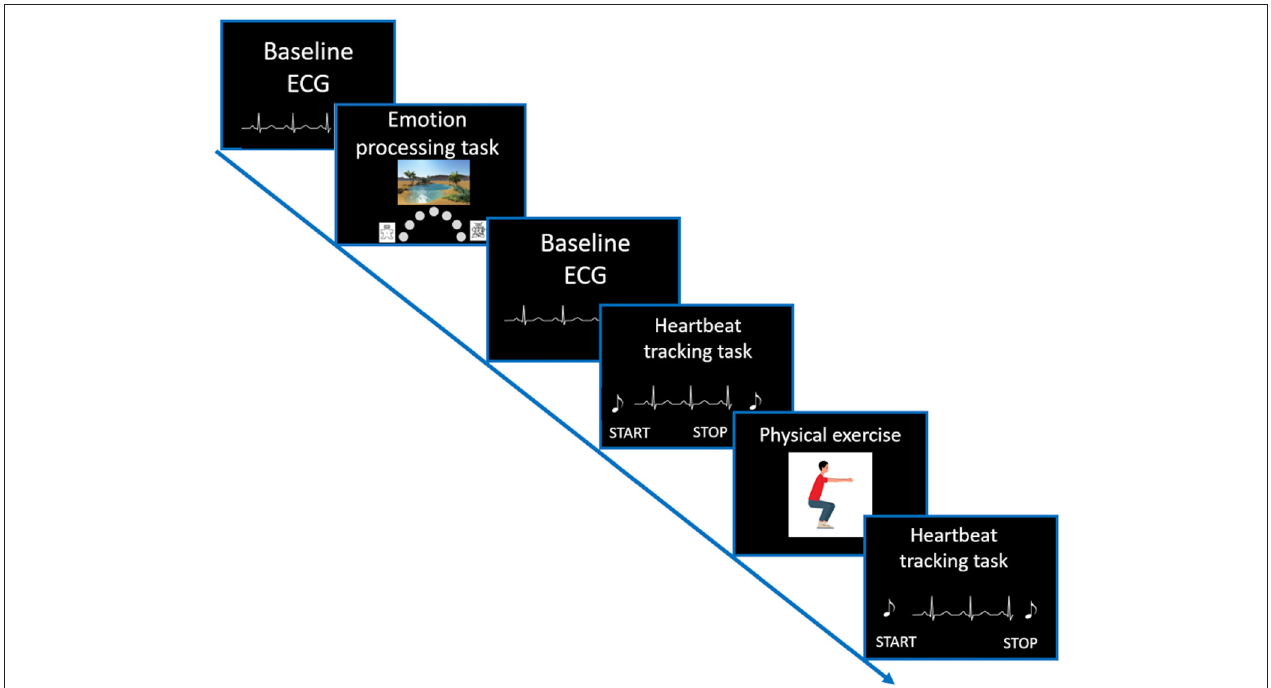
FIGURE 1 | Visualization of the study setup. After completing all questionnaires, a resting ECG (duration of 2min) was recorded. Afterwards, participants performed an emotion processing task. Again, before starting the Heartbeat tracking task, a resting ECG recording was conducted. For more details on the trial structure of the Heartbeat tracking task please see Figure 2